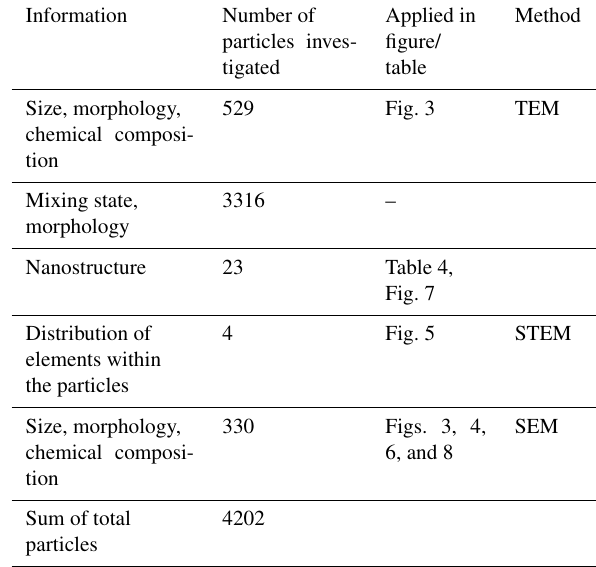
Table 2. Overview of particle parameters